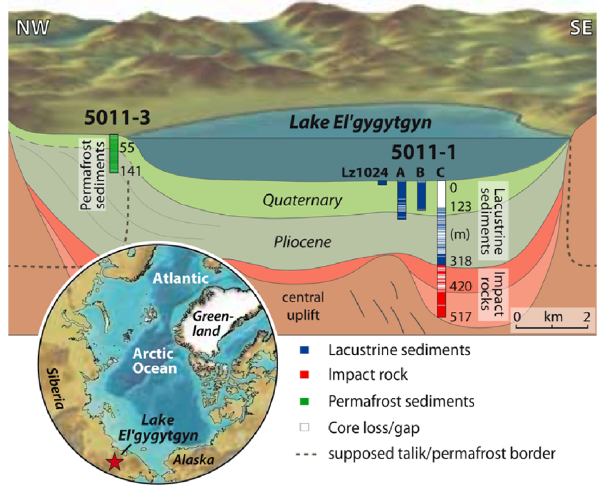
Fig. 1. Location of Lake El’gygytgyn in northeastern Russia (in- serted map) and schematic cross-section of the El’gygytgyn basin stratigraphy showing the location of ICDP Sites 5011-1 and 5011-3. Lz1024 is a 16m long percussion piston core taken in 2003 that fills the stratigraphic gap between the lake sediment surface and the top of drill cores 1A and 1B (from Melles et al.,